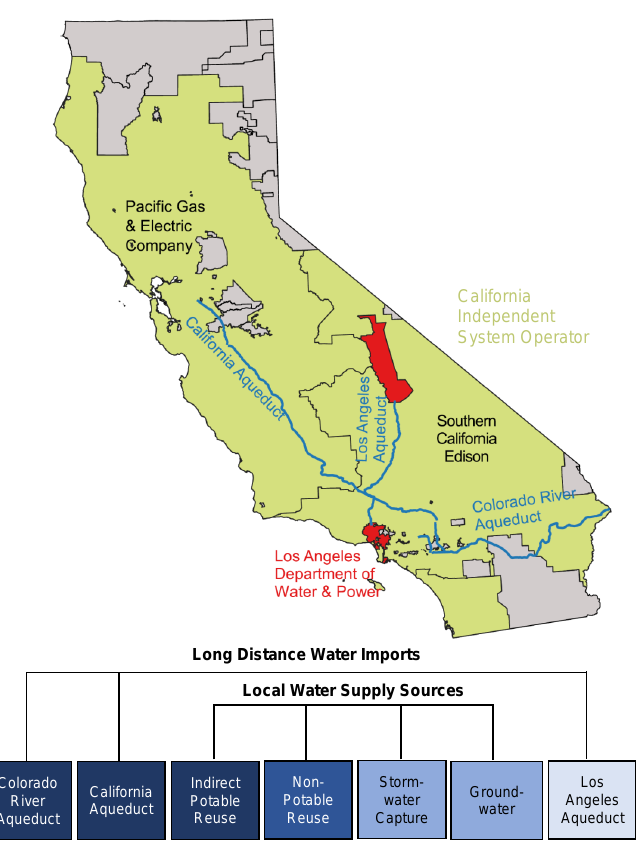
Figure 1. Water supply sources for the Los Angeles Department of Water and Power (LADWP). The areas shown in red and green represent the LADWP and the CAISO (the California Independent System Operator) regions, respectively. The color of each block in the bottom illustration represents the energy intensity of its respective water supply source, where the darkest blue corresponds to the highest energy intensity source and the lightest blue, the